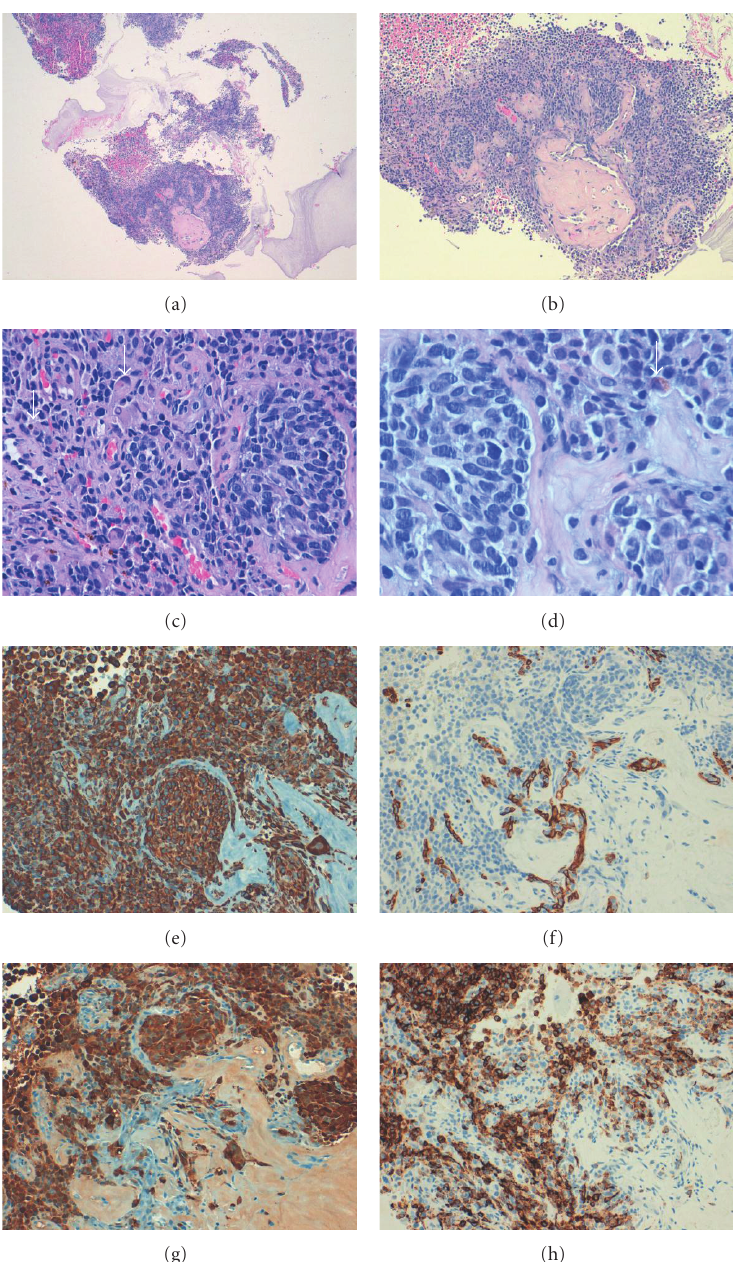
Figure 1: Endometrial biopsy. Histopathologic findings. (a, b, c, and d) Polypoid appearance. The tumor cells arranged in sheets or irregular nests, cytoplasm shows a granular eosinophilic pattern. A dark brown intracytoplasmatic pigment is present (white arrows). Immunohistochemical studies. (e, f, g, and h). S-100 expression, (f) cytokeratin positivity. (g, h). HMB45 and Melan A positivity in neoplastic cells,